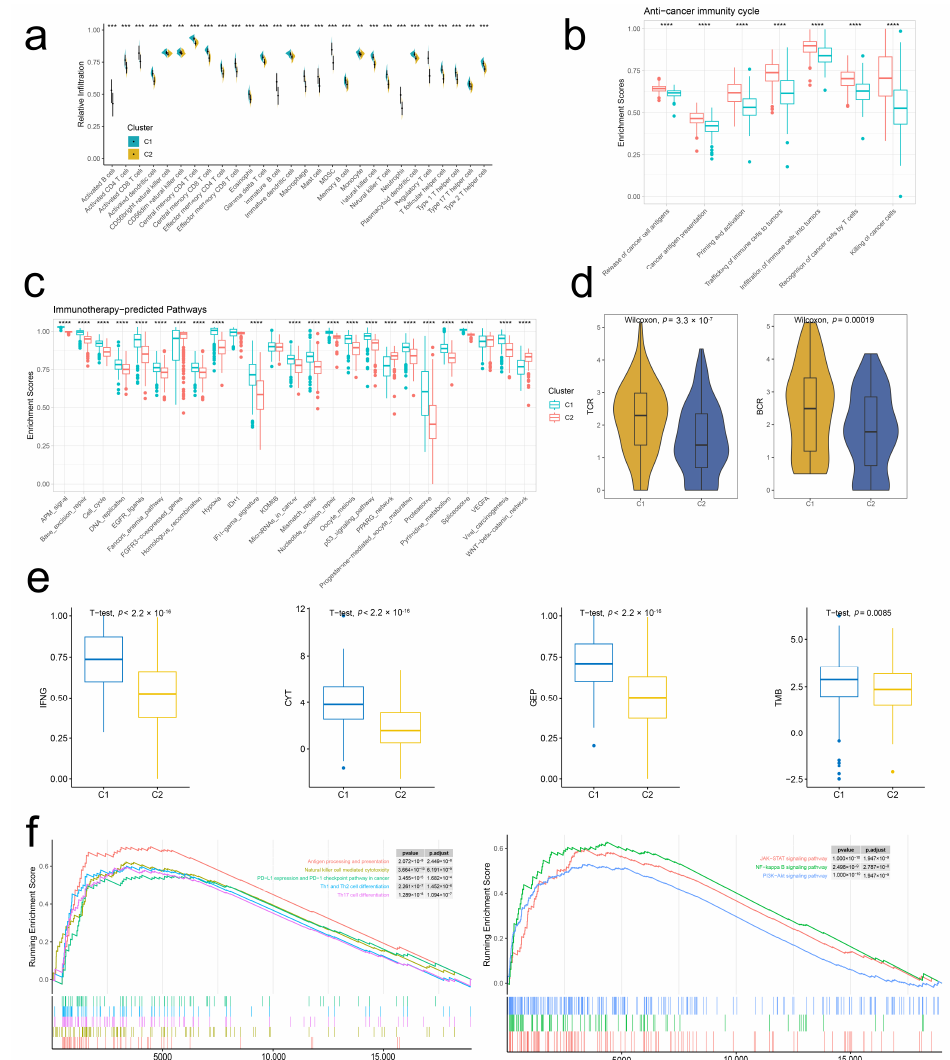
Figure 4. Stem. Sig. models an inflamed TME of TCGA-BLCA. ( a ) The infiltration abundances of 28 immune cell subsets between two clusters. ( b ) The distribution of the enrichment scores of a seven-step anti-tumor cycle between two clusters. ( c ) The distribution of the enrichment scores of immunotherapy-predicted pathways between two clusters. ( d ) The distribution of TCR and BCR evenness between two clusters. ( e ) The distribution of activities of four immunotherapy-predicted factors between two clusters. ( f ) Upregulated pathways in cluster 1. ** p <0.01, *** p <0.001, **** p <0.0001.